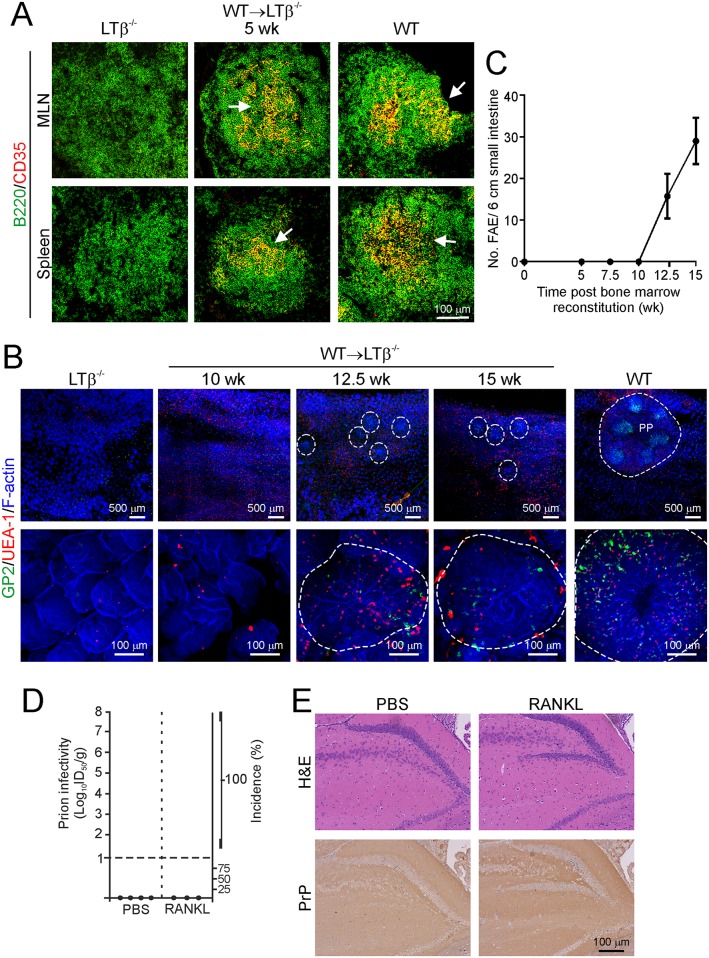
Villous M cells induced by RANKL-treatment do not enhance the transport prions to the mesenteric lymph nodes (MLN).This experiment aimed to determine whether the enhanced prion pathogenesis we observed in RANKL-treated C57BL/6 mice wild-type (WT) mice was due to the increased uptake of prions by the M cells induced in the villous epithelium. A mouse model was created in which their small intestines lacked follicle associated epithelia (FAE) and M cell-containing gut-associated lymphoid tissues, but possessed follicular dendritic cells (FDC) in their MLN. A-C) Peyer’s patches-deficient LTβ-/- mice were γ-irradiated and reconstituted with WT bone marrow (WT→LTβ-/- mice) and tissues from 3–4 mice examined at intervals afterwards. LTβ-/- mice and WT mice were included as controls. A) Immunohistochemical analysis revealed that the development of FDC (CD35+ cells, red) in the B cell-follicles (B220+ cells, green) of MLN (upper panels) and spleens of WT→LTβ-/- mice was restored by 5 wk after bone-marrow reconstitution. Images are representative of 3–4 mice/group. B) Beginning at 5 wk post-reconstitution, and at 2.5 wk intervals thereafter, 3 individual 2 cm pieces of intestine/mouse were whole-mount immunostained to detect M cells (GP2+ cells, green) and goblet cells (UEA-1+ cells, red). F-actin (blue) was used as a counterstain. Characteristic epithelial structures that contained GP2+ M cells and resembled the FAE covering isolated lymphoid follicles were absent in the intestines of LTβ-/- mice (left-hand panels) but were detectable from 12.5 wk post-reconstitution in WT→LTβ-/- mice. FAE highlighted by broken lines in WT→LTβ-/- panels. The broken line in the upper right-hand WT panel highlights 6 individual FAE covering a Peyer’s patch. Images are representative of 3–4 mice/group. C) The total no. FAE across the 3 individual 2 cm intestinal pieces were counted (n = 3–4 mice/group). D) WT→LTβ-/- mice were prepared as above and at 7.5 wk post reconstitution (when FDC present but FAE absent) were treated with RANKL for 4 d (or PBS as a control) to induce the differentiation of villous M cells in the intestine. Between the 3rd and 4th treatments, the mice were subsequently orally-exposed to a 1% dose of ME7 scrapie prions, and MLN were collected 28 d later (n = 3–4 MLN/group). Prion infectivity titres (log10 ID50/g tissue) were determined by injection of MLN tissue homogenates into groups of 4 tga20 indicator mice. Each symbol represents data derived from an individual MLN. Data below the horizontal line indicate disease incidence in the recipient mice <100% and considered to contain trace levels of prion infectivity. E) Confirmation that none of the brains from the clinically-negative tga20 indicator mice injected with MLN from PBS- or RANKL-treated donors contained histopathological signs of prion disease at the end of the experiment (200 d post-injection): spongiform pathology (H&E, upper panels), or PrPd deposition (lower panels). Sections were counterstained with haematoxylin to detect cell nuclei (blue). Images are representative of 12–16 mice/group.